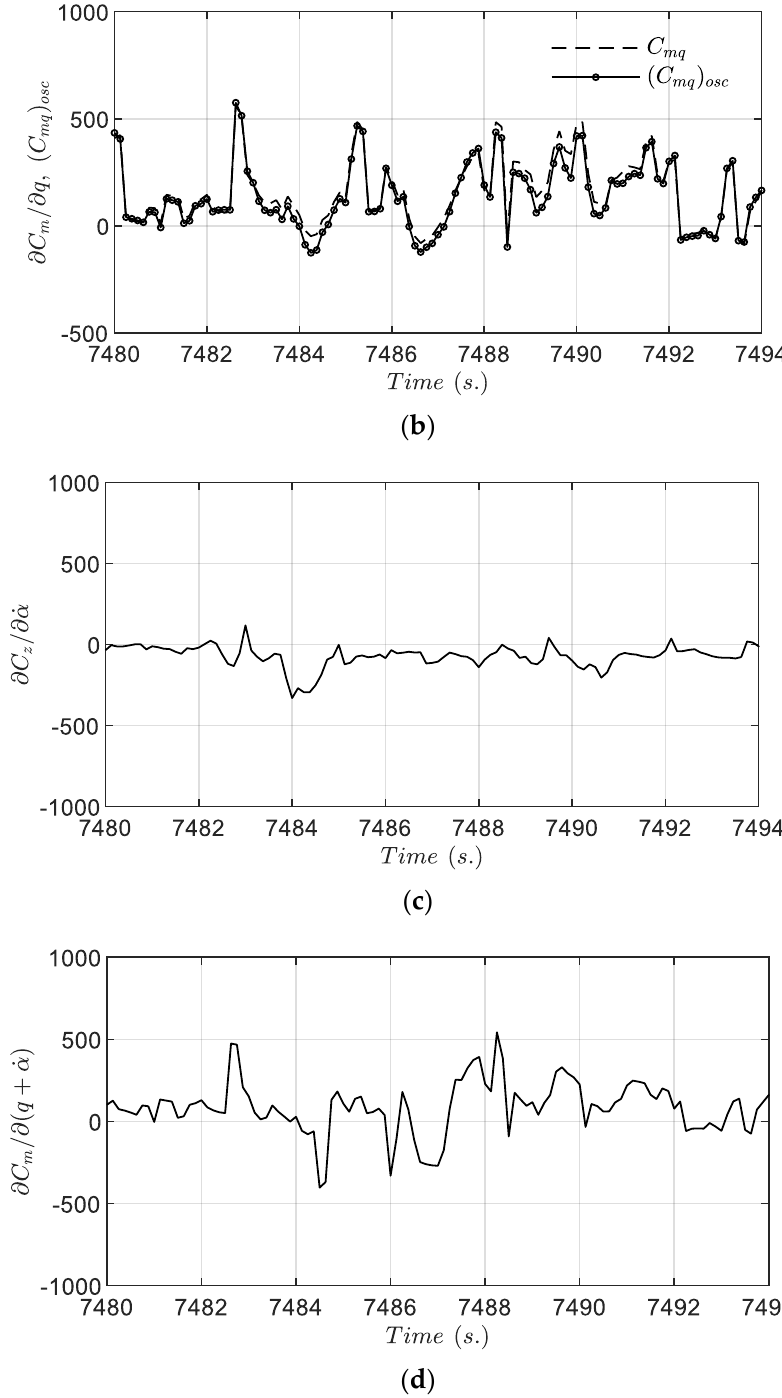
Figure 6. Time history of main longitudinal oscillatory derivatives along the flight path. ( a ) Time history of ( C zq ) osc ; ( b ) Time history of ( C mq ) osc and C mq ; ( c ) The effects of -derivatives on C z ; ( d ) Time history of the dynamic derivatives of stability.